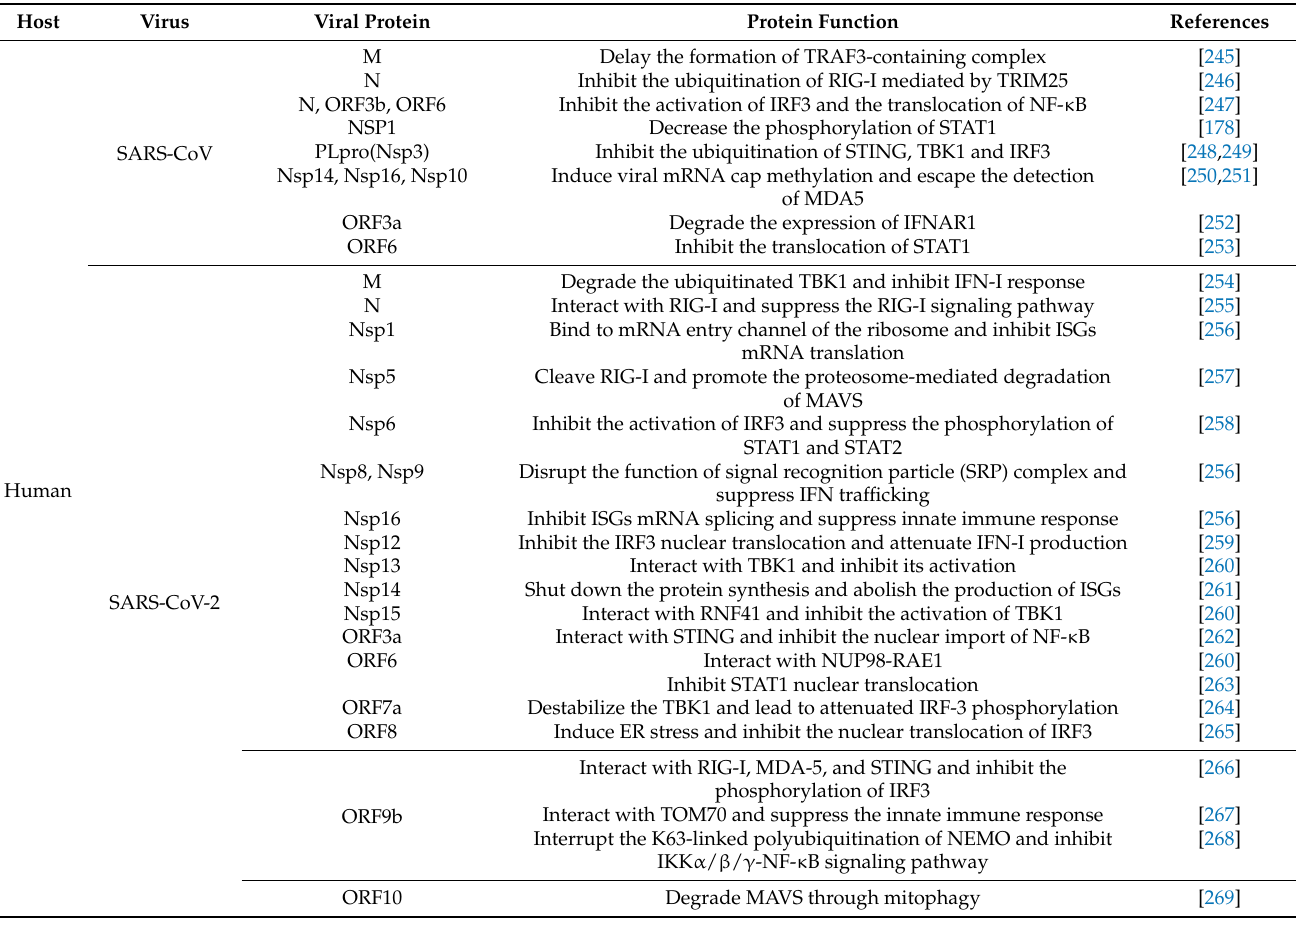
Table 3. The roles of coronavirus proteins in innate immune response across the species. Virus Viral Protein Protein